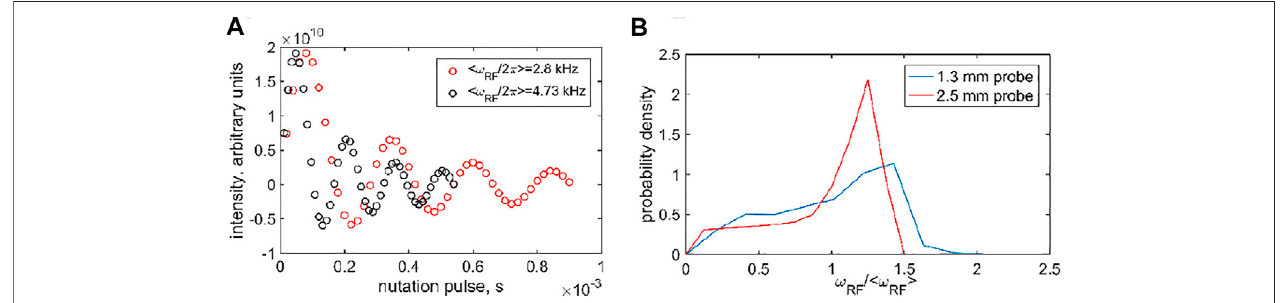
FIGURE 1 | (A) Examples of the 2 H nutation measurements used to determine RF inhomogeneity, shown for the 1.3 mm Bruker HXY probe using the DMS-D 6 central band intensity at the 60 kHz MAS rate at 14.1 T. (B) Resulting inhomogeneity pro fi les, obtained as the Fourier analysis of the nutation data, as a function of ω < ω > obtainedfora < ω > rangeof2.8 – 20 kHzforthe1.3 mmBrukerHXprobeusingDMS-D RF / RF RF